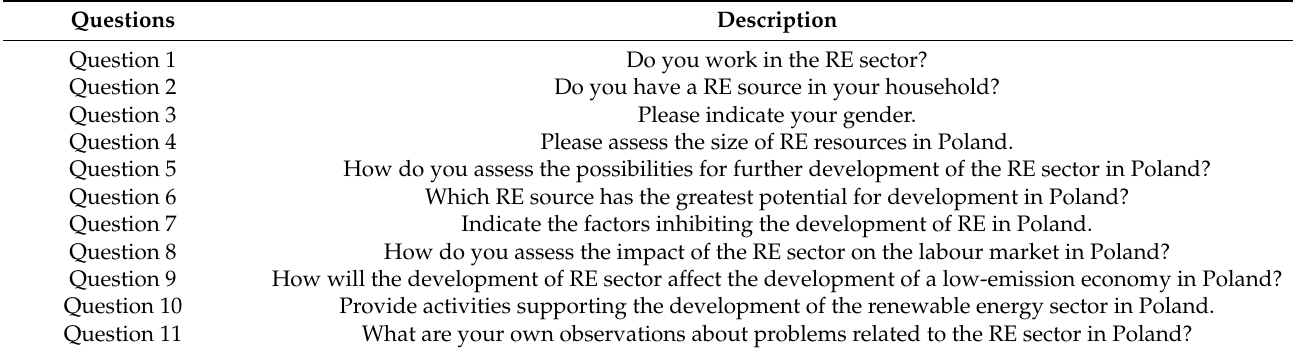
Table 2. Questionnaire survey questions.